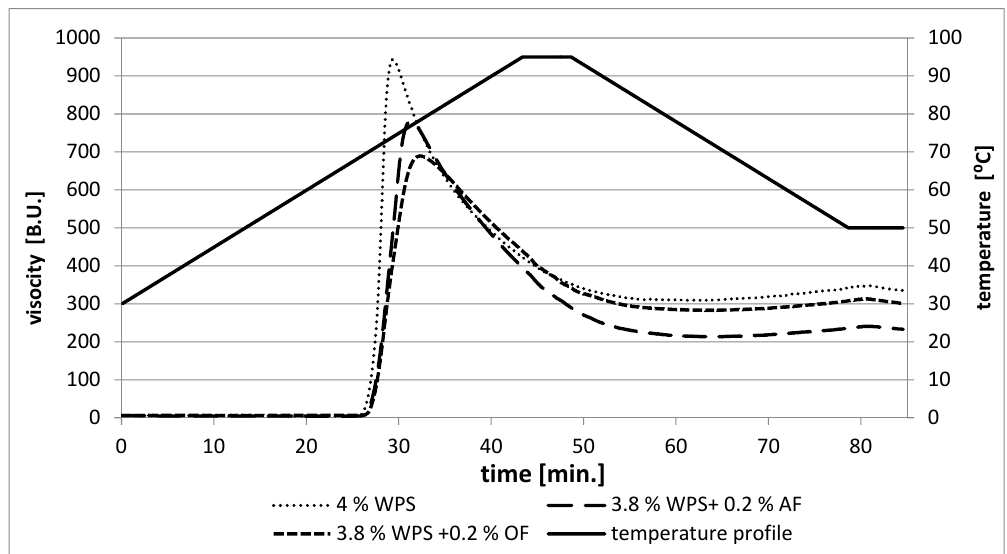
Figure 1. Pasting characteristics of 3% waxy potato starch and its mixtures with selected plant fibers (waxy potato starch (WPS), oat fiber (OF), apple fiber (AF)).